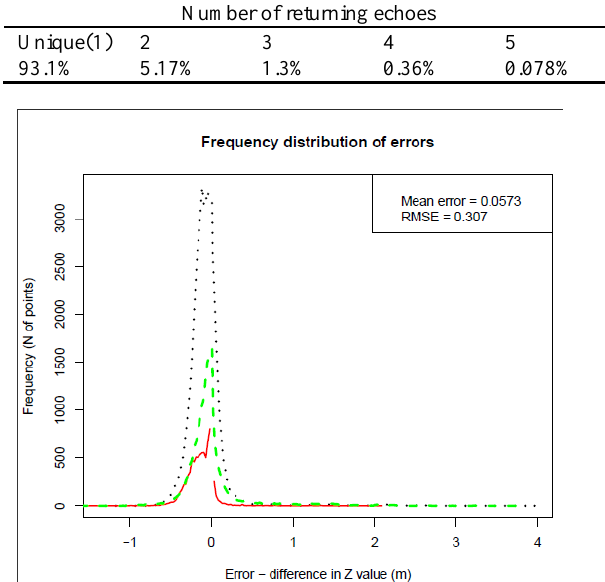
Figure 9. Error frequency distribution of DTM. Continuous red, dashed green and dotted black lines respectively represent left, center and right transects.